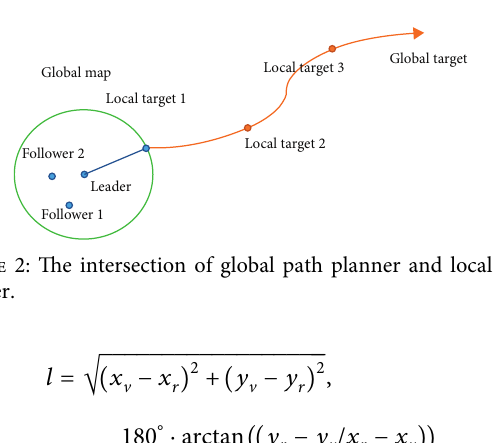
Figure 1: The influence of attitude adjustment angle on the se- lection of the nearest